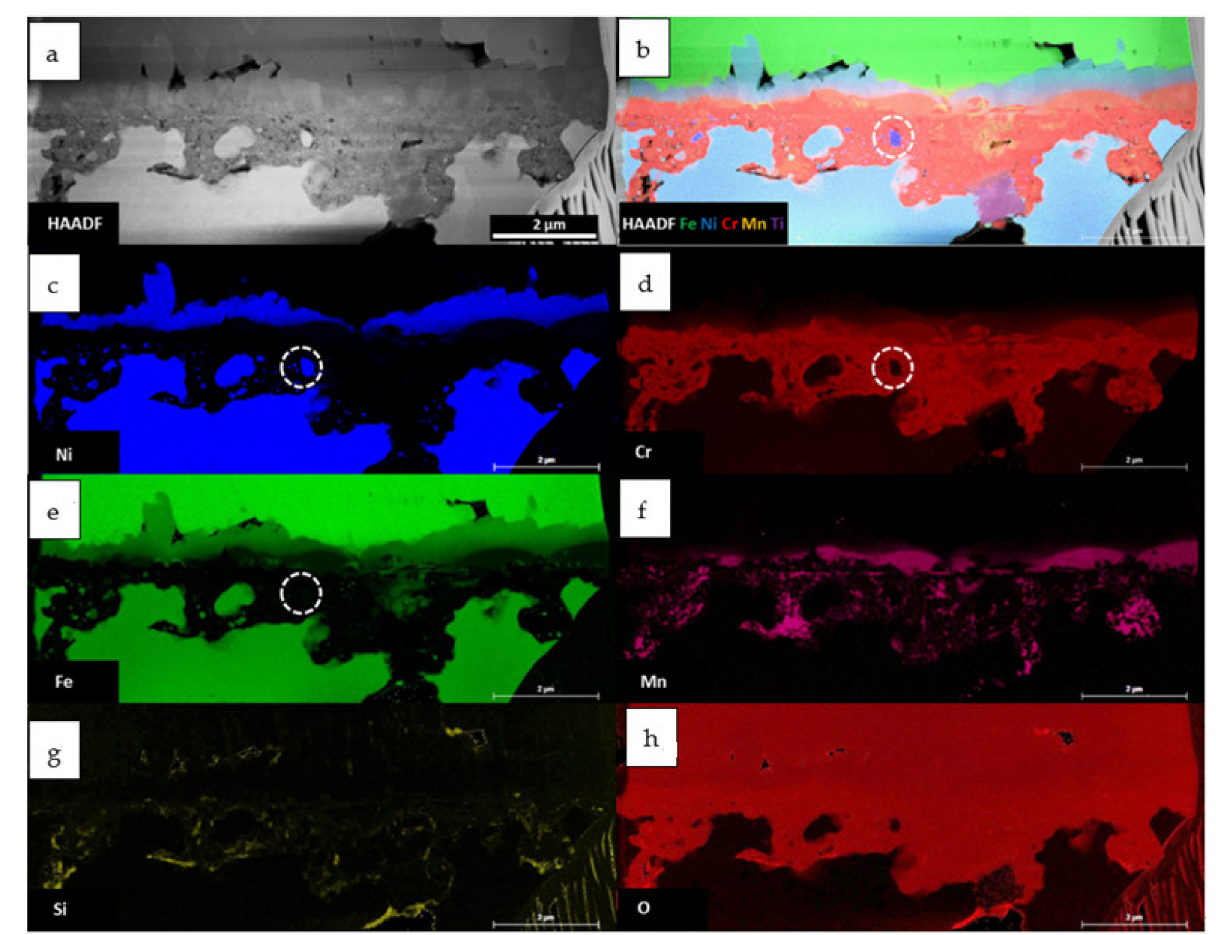
Figure 6. A STEM-EDS analysis of the oxide scale. ( a ) region of interest (STEM-HAADF), ( b ) compositional images of the selected elements, ( c – h ) elemental maps of the selected